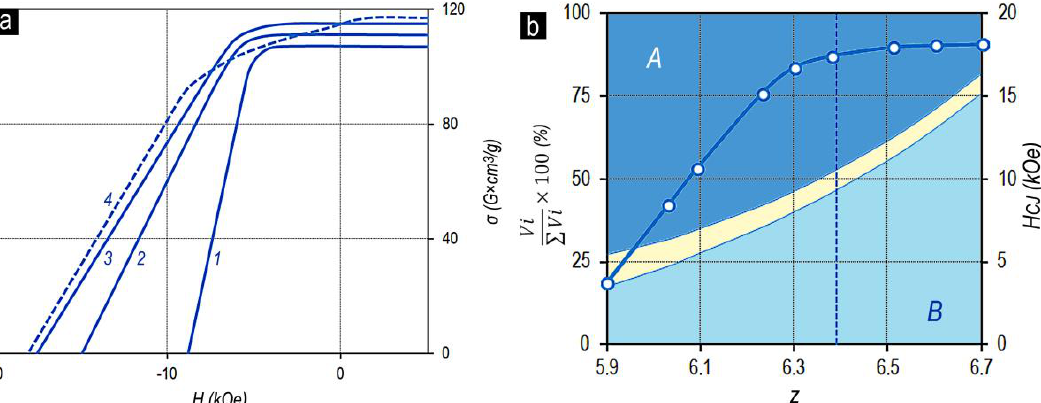
Figure 7. ( a ) Magnetization reversal portions of major hysteresis loops and ( b ) dependences of the volume percentage of structural phase components A, B, and C ((V i / Σ V i )x100) and coercive force (H CJ ) of the Sm 0.85 Zr 0.15 (Co 0.665 Cu 0.075 Fe 0.260 )z alloys with z = 6.0(1); 6.2(2); 6.4(3) and 6.5(4) on the chemical composition z (VSM, without allowance for the demagnetizing factor, N = 1/3).